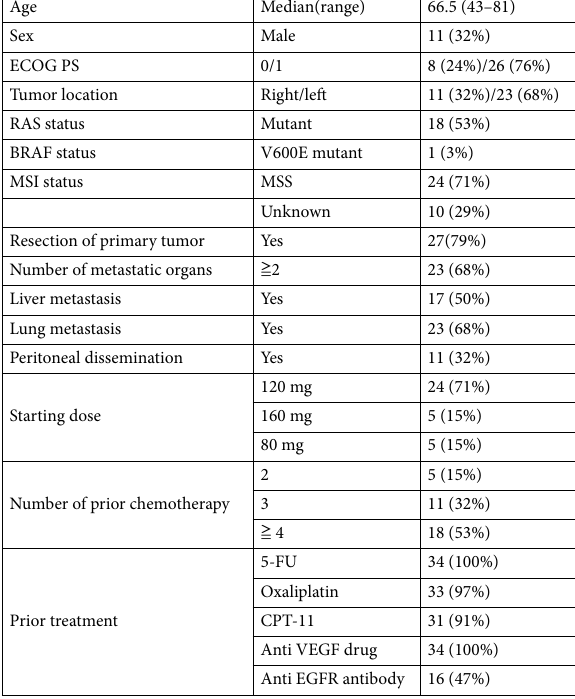
Table 1. Patients characteristics. ECOG Eastern Cooperative Oncology Group, PS performance status, MSI microsatellite instability, MSS microsatellite stable5-FU, 5-fluorouracil, CPT-11 irinotecan, VEGF vascular endothelial growth factor, EGFR epidermal growth factor receptor.